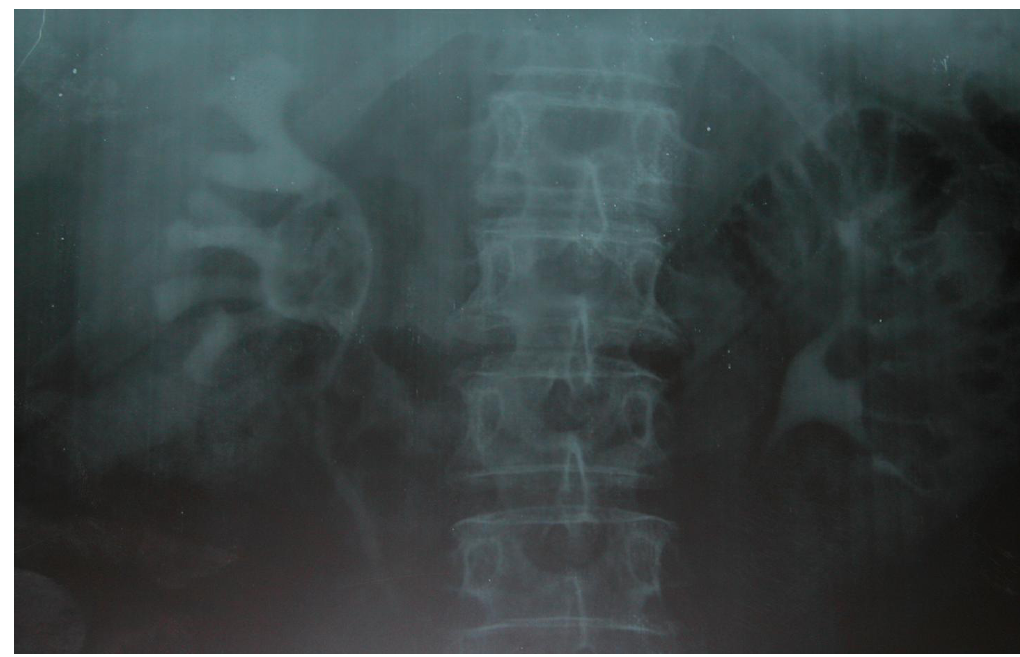
FIGURE 3. Intravenous urography: large filling defect of the renal pelvis due to partially radiolucent material.